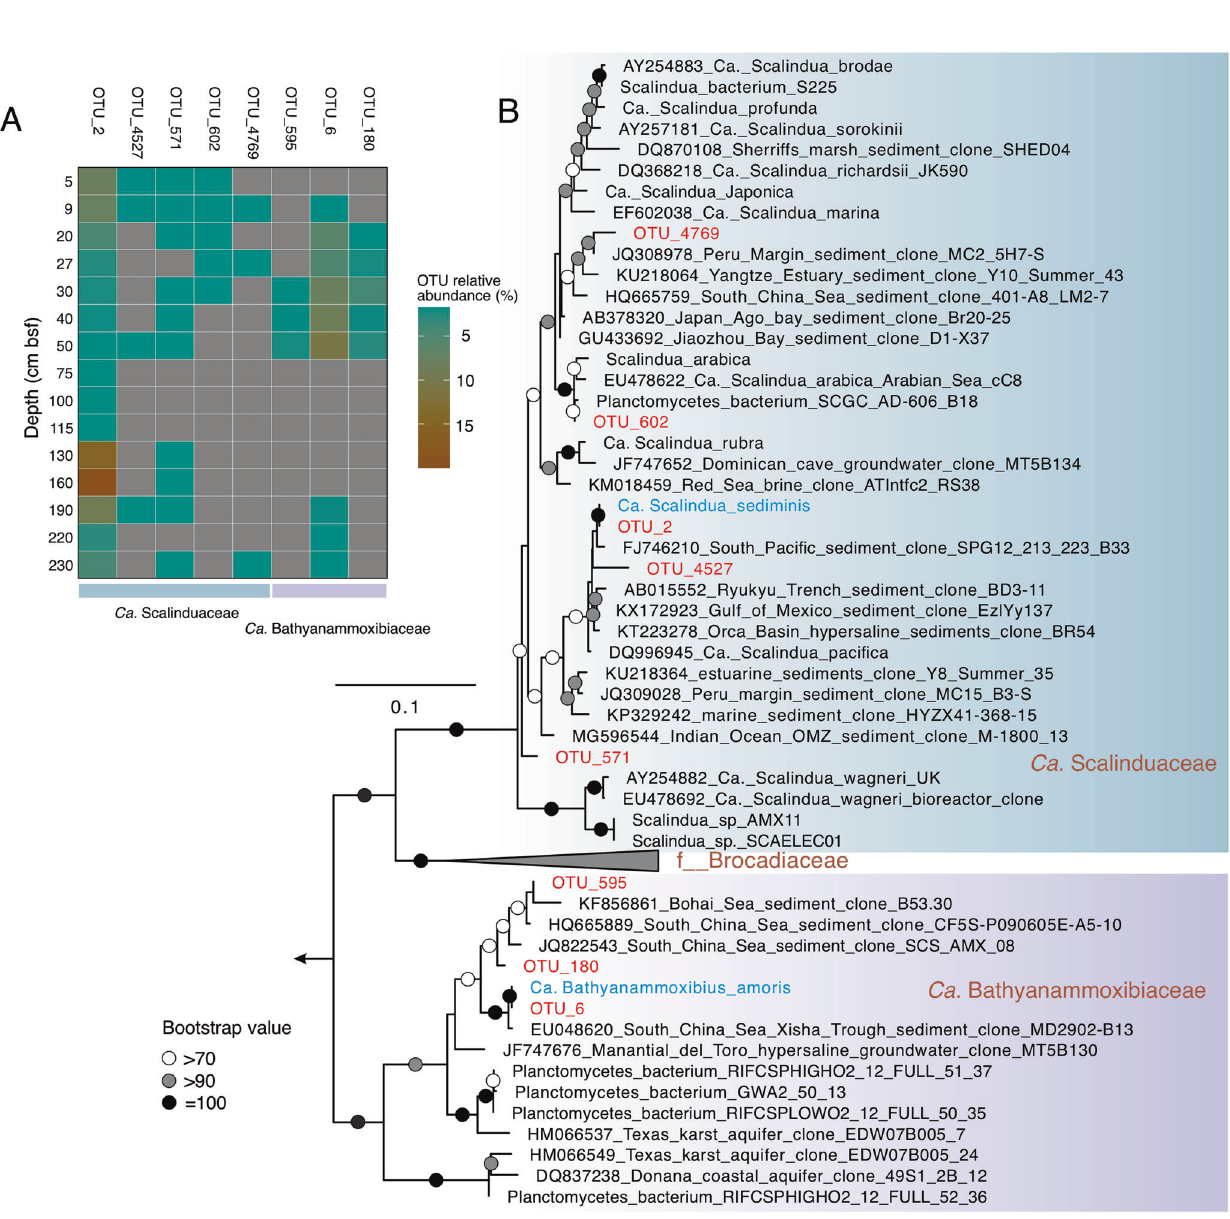
Fig. 3 Distribution and phylogeny of anammox bacteria in GS14-GC04. A A heatmap showing the occurrence and relative abundance of eight anammox OTUs in the investigated sediment layers. The taxonomic classi fi cation of the individual OTUs, showed at the bottom of the heatmap, is based on the phylogenetic placements in ( B ). B Maximum-likelihood phylogenetic tree of anammox bacteria. Anammox bacteria OTUs (97% identity cutoff) recovered from GS14-GC04 are highlighted in red. The two genomes recovered from AMOR sediments are highlighted in blue. The bar indicates estimated sequence divergence per residue. The robustness of the tree was evaluated by 1,000 times of ultrafast bootstrap iteration, and bootstrap values higher than 70 are shown by symbols indicated in the legend. GS14-GC04 and GS16-GC04, the relative abundance of NOB To assess the contribution of anammox bacteria to nitrite af fi liated with the bacterial genera Nitrospira and Nitrospina were consumption, we also quanti fi ed the contemporaneous distribu- observed to increase with depth in the shallow sediments, and tions of nitrite-oxidizing and nitrite-reducing bacteria, the other then decrease to low levels (<0.5% of the total communities) in two functional groups involved in nitrite consumption. In both ISME